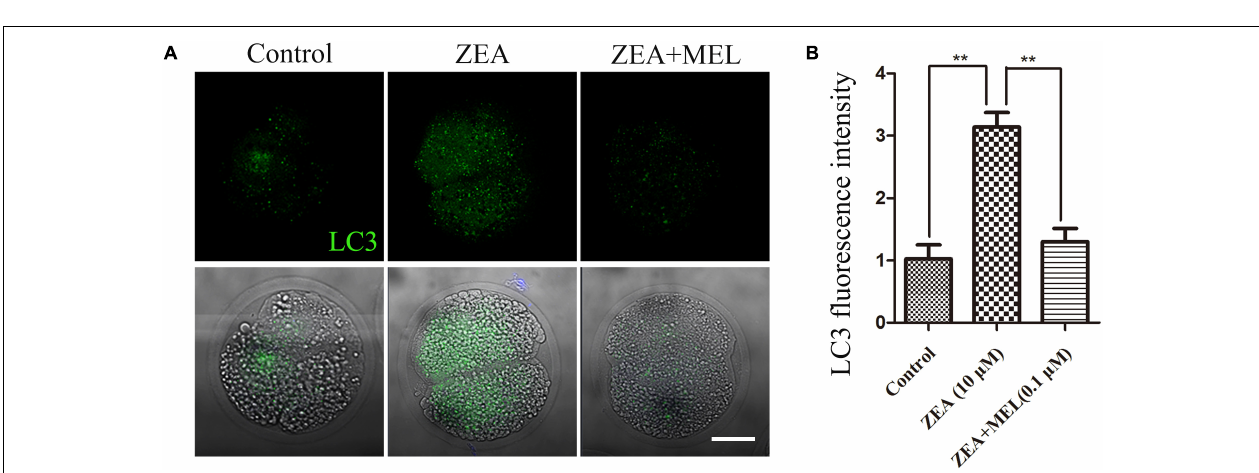
FIGURE 4 | The effect of ZEA and co-exposure of ZEA and melatonin on DNA damage in porcine embryos. (A) Representative images of γ H2A.X (red) in the embryos from the control, ZEA-exposed, and ZEA+MEL groups. Bar = 20 µ m. (B) γ H2A.X fluorescence intensity in control, ZEA-exposed, and ZEA+MEL groups, and fluorescence images were measured by confocal microscope with the same settings and parameters. ∗∗ P < 0.01.